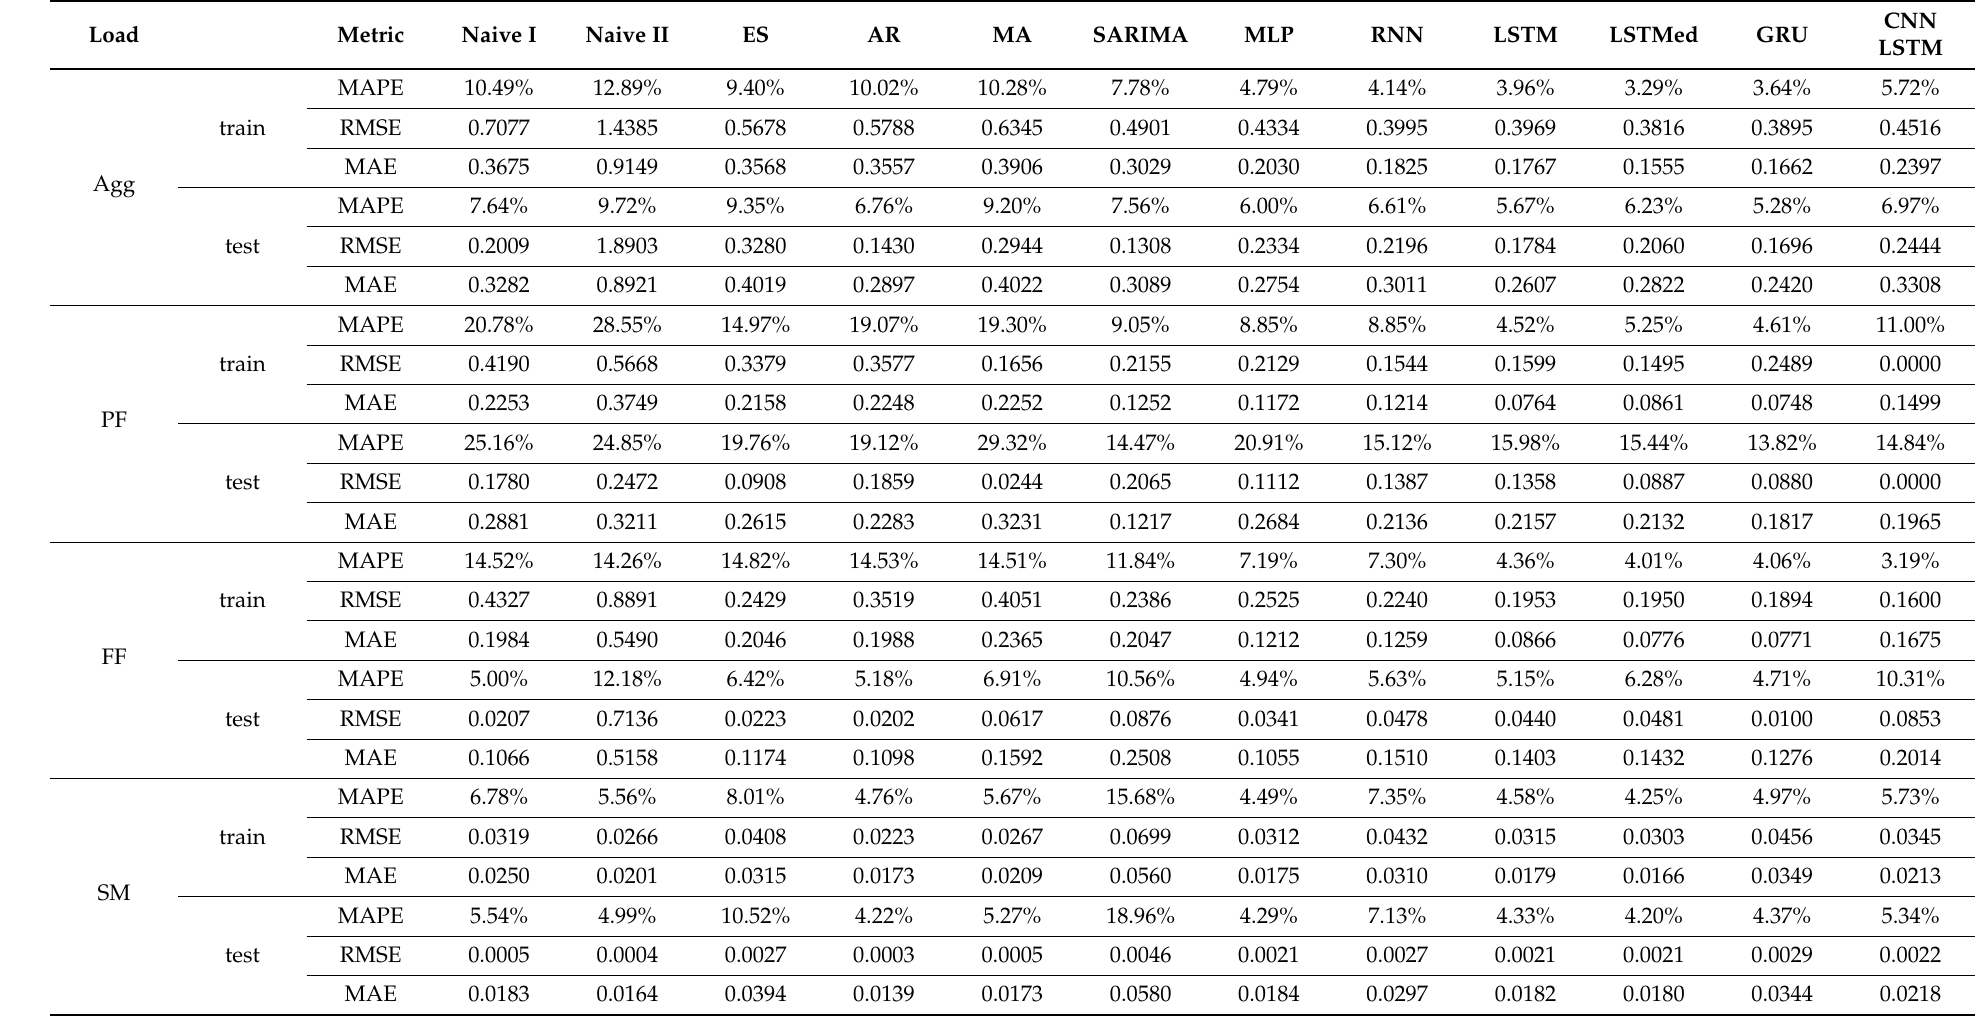
Table 5. Results for 24 h ahead forecasts for aggregated and individual load